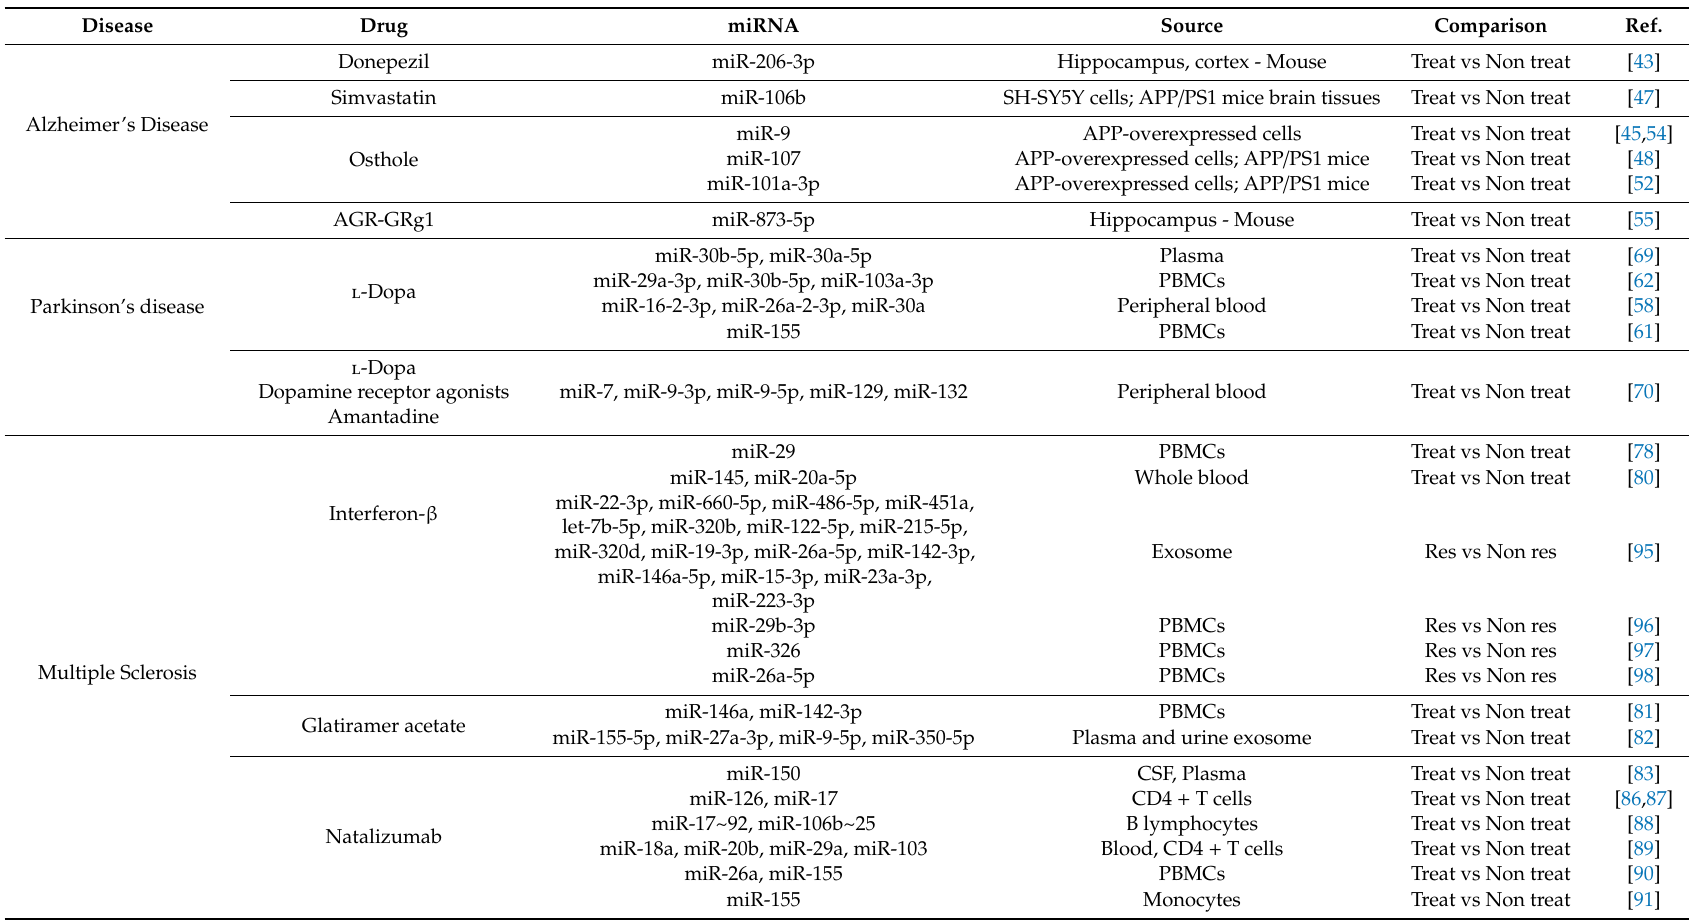
Table 1. List of miRNAs involved into therapeutic e ff ects of available conventional (and non-conventional) treatments for some NDDs. For each disease, the investigated drug, the di ff erentially expressed miRNAs, their source, the type of comparison and the published papers are